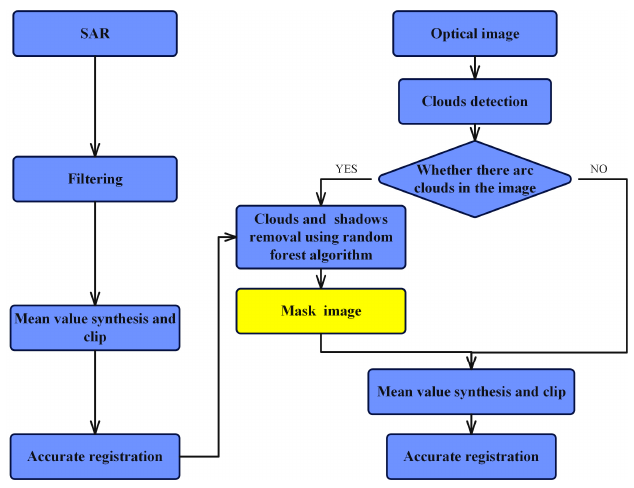
Figure 4. Image preprocessing.